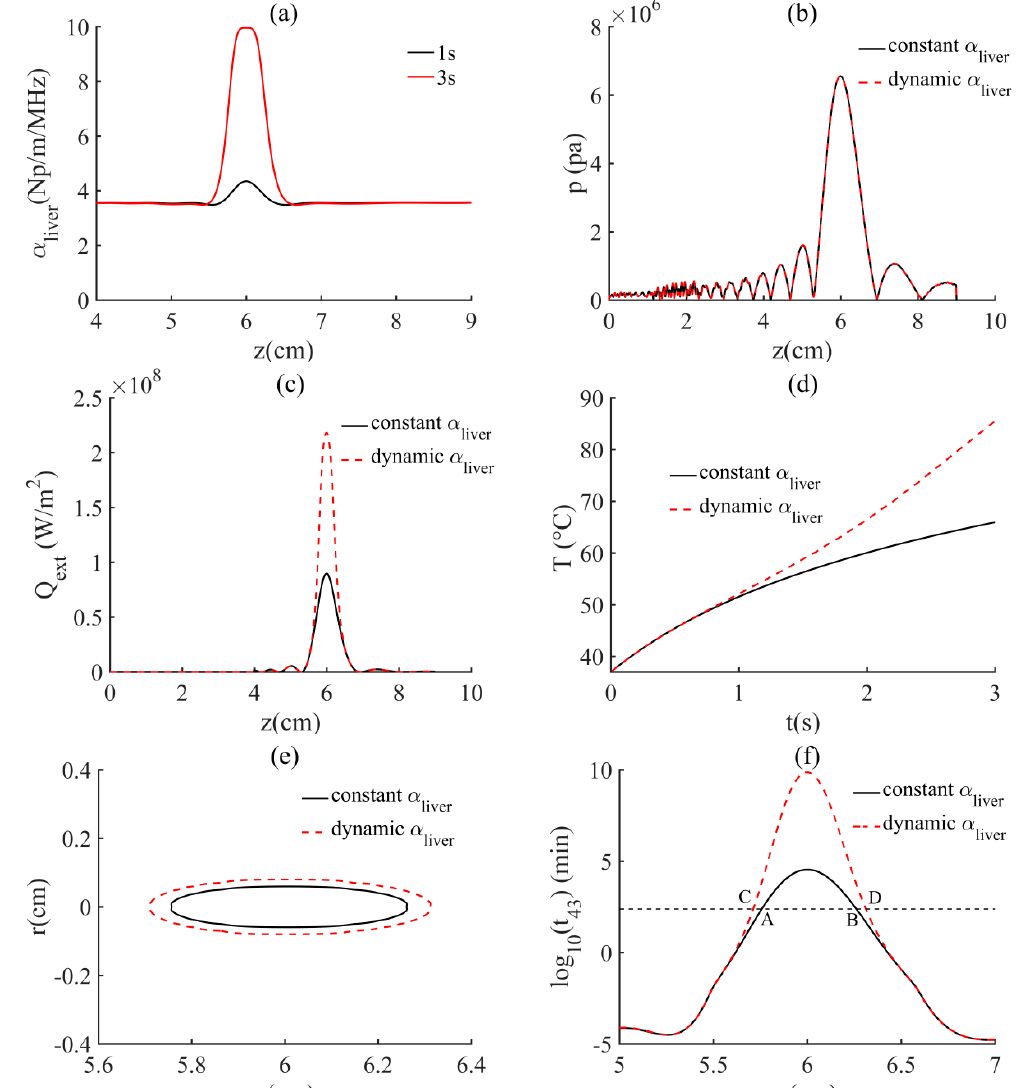
α at t = 1 s and 3 s. The effects of the dynamic acoustic absorption Figure 4. ( a ) The evolution of Figure 4. ( a ) The evolution of α liver at t = 1 s and 3 s. The effects of the dynamic acoustic absorption liver coefficient on: ( b ) p ( c ) Q ext ( d ) T at the ultrasonic focus ( e ) thermal damage zone ( f ) t 43 at t = 3 coefficient on: ( b ) p ( c ) ext Q ( d ) T at the ultrasonic focus ( e ) thermal damage zone ( f ) s.